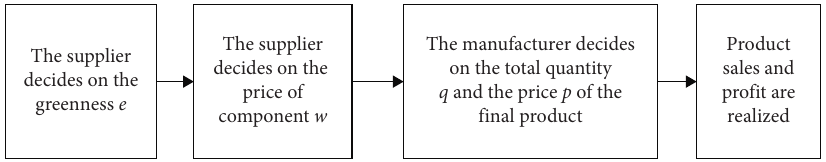
Figure 1: Sequence diagram of the supplier’s decision single green